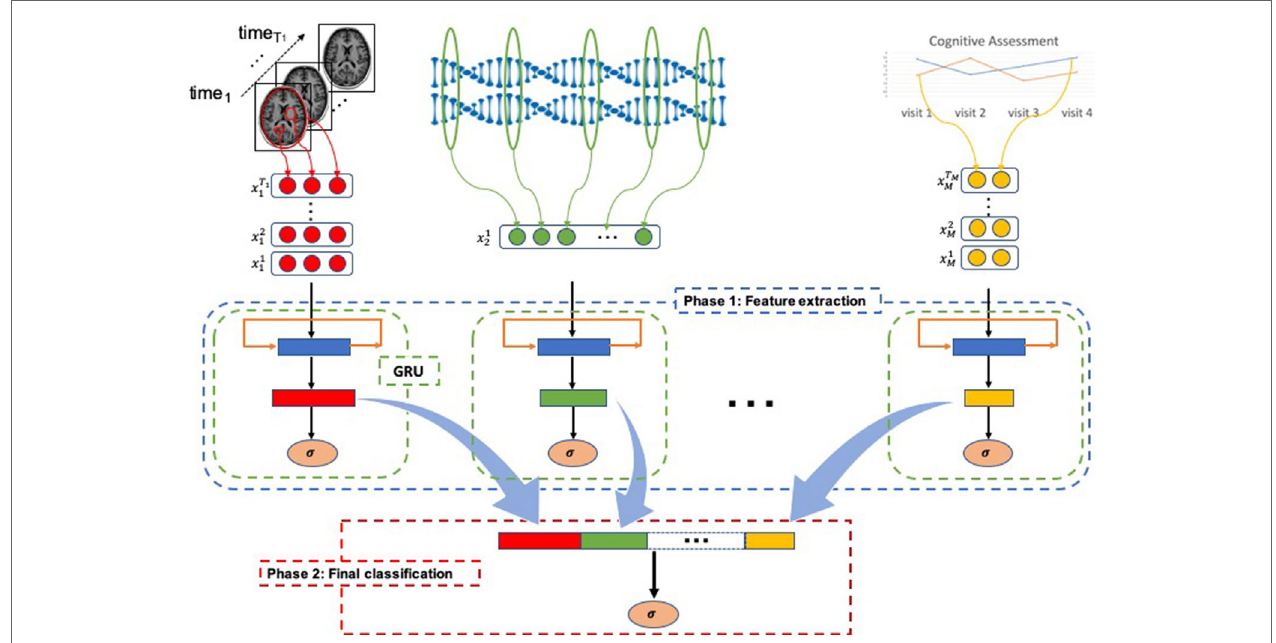
FIGURE 1 | Longitudinal total intracranial volume, hippocampal volume, and entorhinal cortex thickness from brain imaging data, genomic data, cognitive assessment, and any forms of numerical data that can be taken using our framework. In phase 1 (blue-dashed rectangle), each modality of data is separately processed for learning feature representation. Both time series and non-time series data can be accepted to produce fixed-size feature vectors using a gated recurrent unit (GRU) component (green-dashed rectangle). Then, the learned representations (rectangles colored by red, green, and yellow) are simply concatenated to form an input for logistic regression (LR) classifier in phase 2 (red-dashed